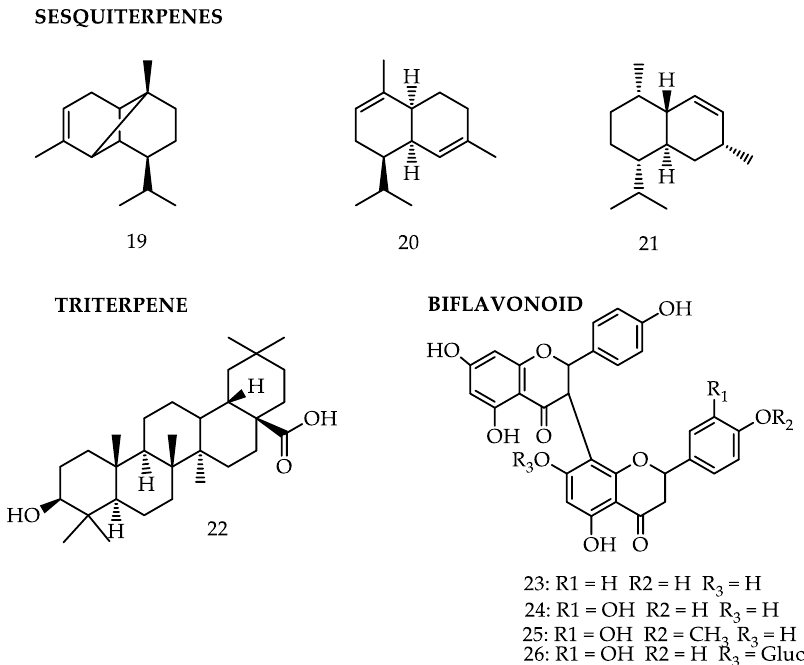
Figure 2. Bioactive compounds of Garcinia gardneriana.